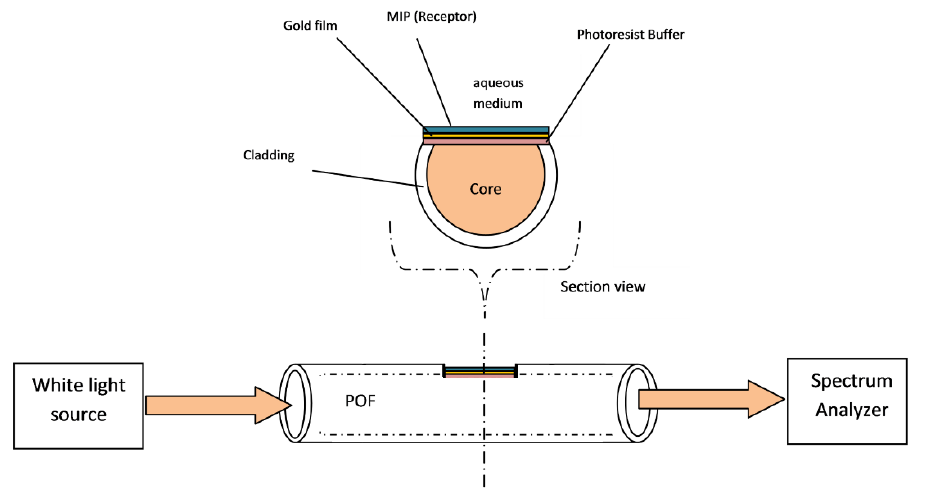
Figure 6. SPR sensor based on D-shaped POF (D-shaped POF-MIP-SPR).